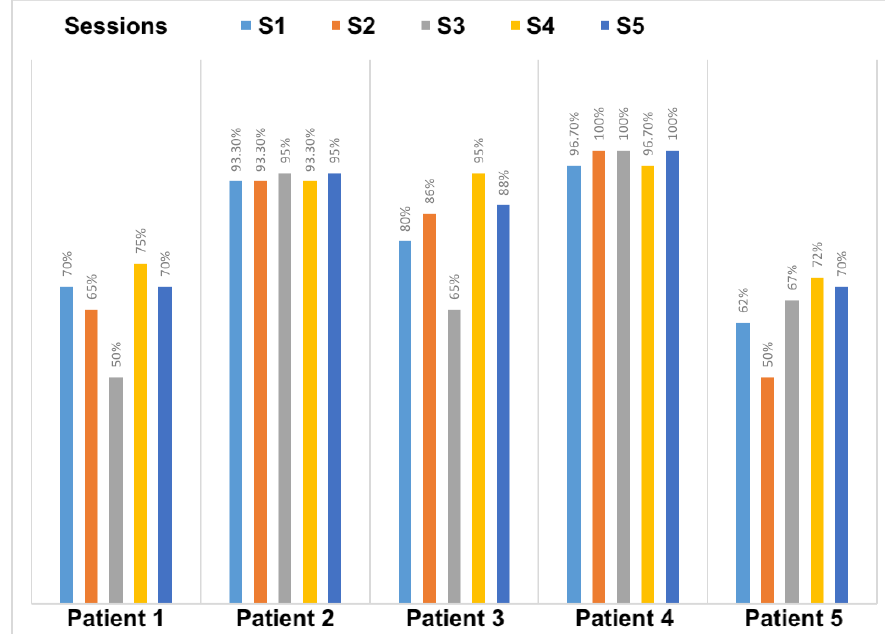
Figure 15. Percentage of achievement and correctness with respect the prescribed